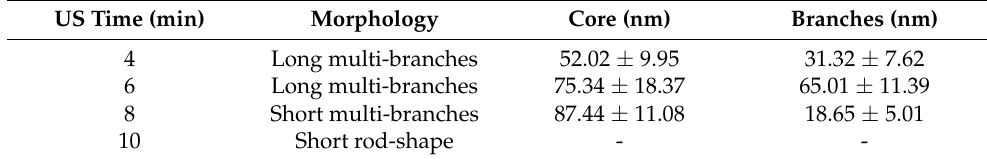
Table 10. The influence time sonication to morphology, average core and branches of GNS.